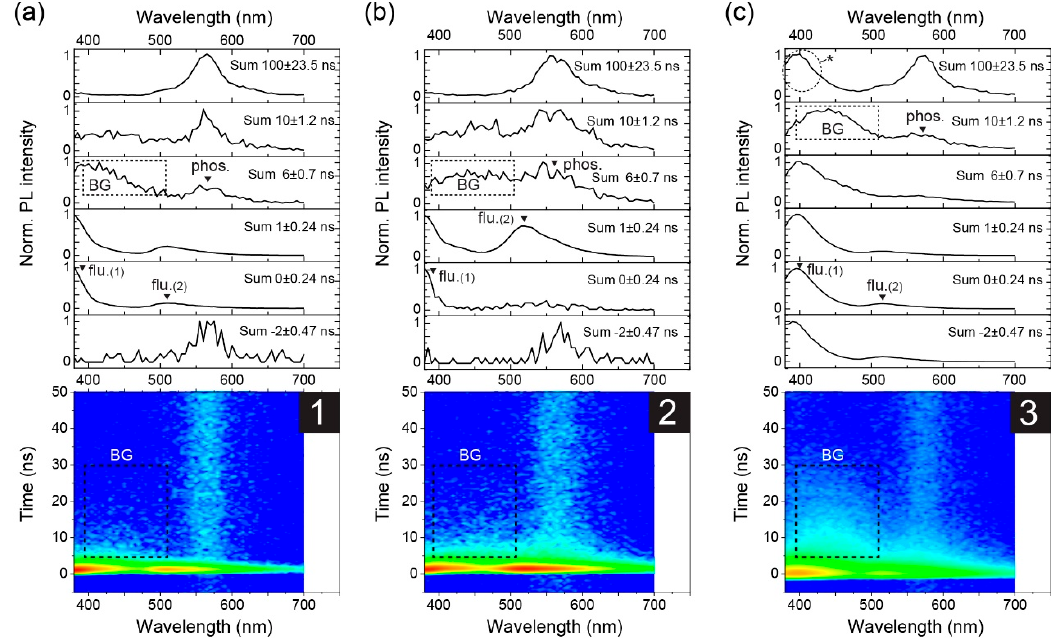
Figure 6. Time-dependent PL spectra of ( a ) 1 , ( b ) 2 , and ( c ) 3 in toluene solutions with N 2 bubbling measured by TCSPC: (top) Normalized PL spectra selected at each time region, (bottom) contour map of the time-resolved results. The square region with the broken line [denoted to BG (background)] in ( c ) is the scattered light from the sample solutions. The circle region in ( c ) noted by * is a characteristic of our TCSPS setup (see Figure S7). The repetition rate of the excitation laser is 1 MHz. The RTP bands seen at -2 ns are caused by the high repetition rate close to the microsecond lifetime of RTP.